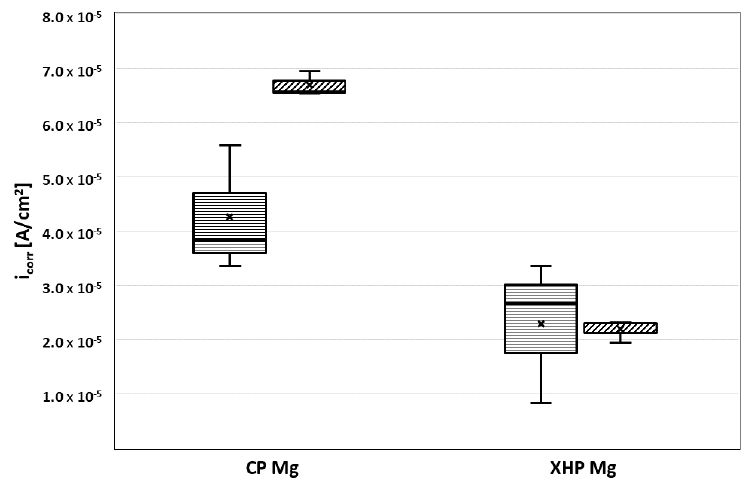
Figure 10. The i corr for static and dynamic conditions for XHP Mg and cp Mg in MEM.